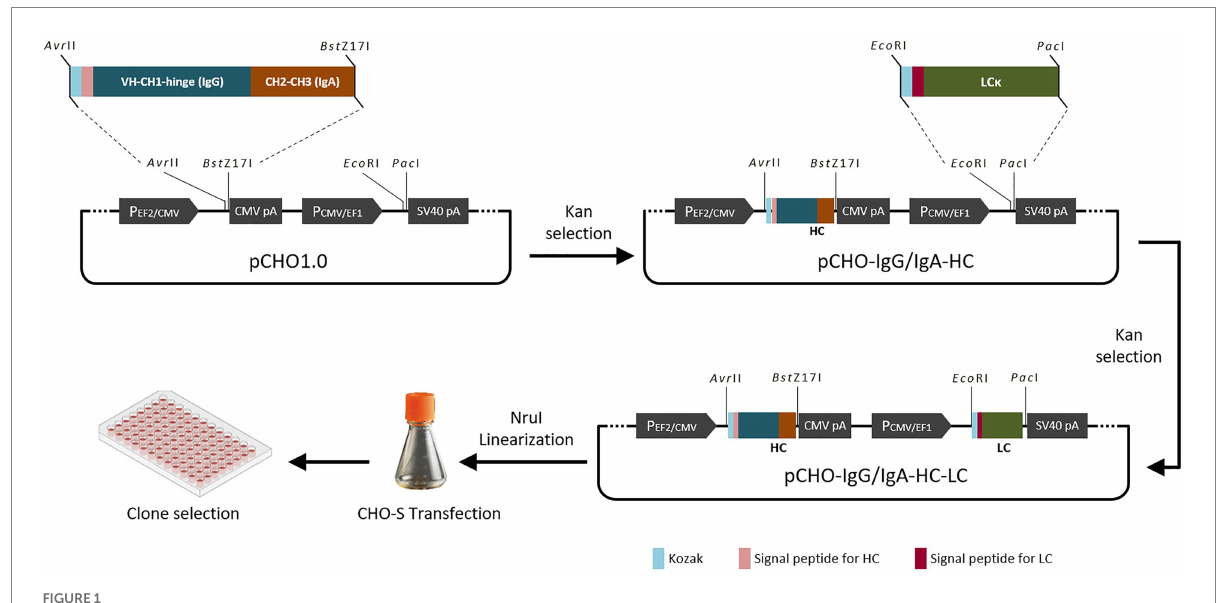
FIGURE 1 Schematic diagram of chimeric antibody